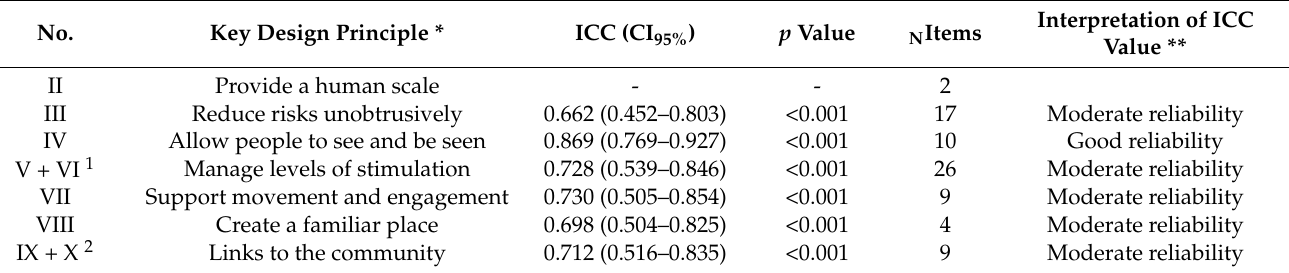
Table 2. Interclass correlation coefficients on German Environment Audit Tool (G-EAT)